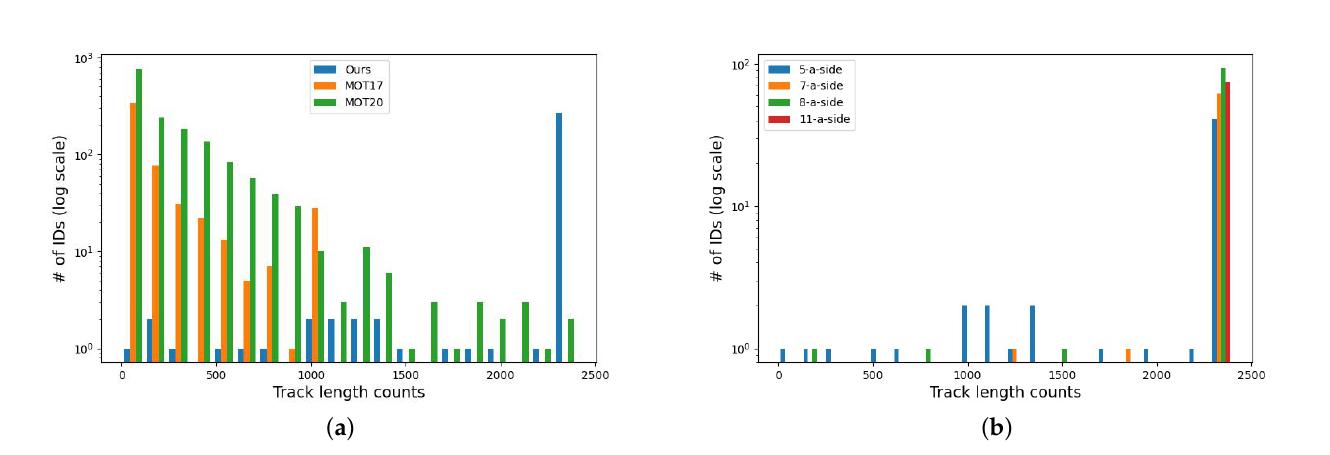
Figure 7. Track counts of each Id in clips. ( a ) Comparison between our dataset and MOTChallenge dataset. ( b ) Comparison between subdatasets of our